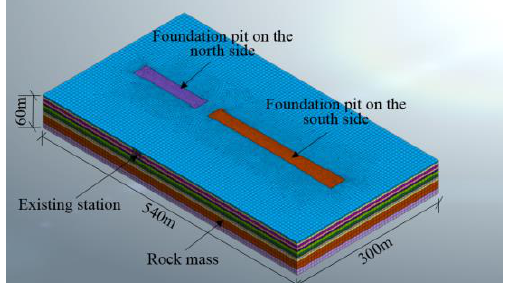
Figure 14. Numerical model diagram.